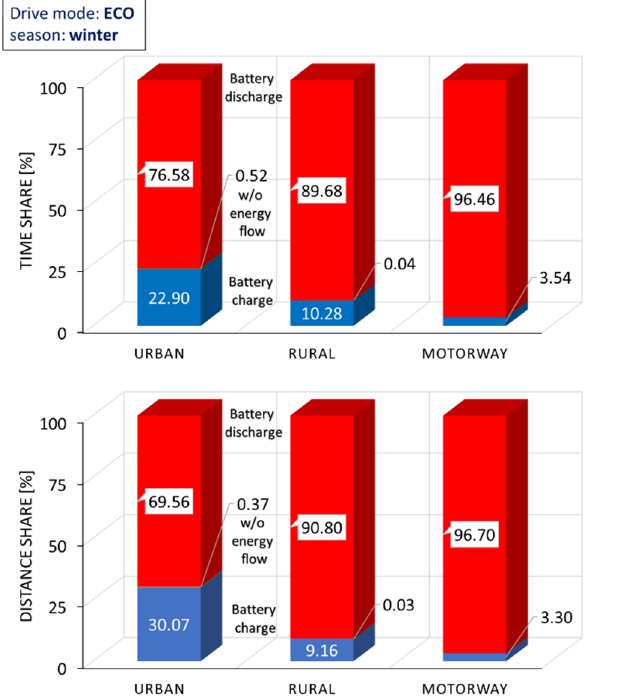
18 of 23 Table 3. Summary of vehicle energy consumption estimated on 100 km distance. Driving Period